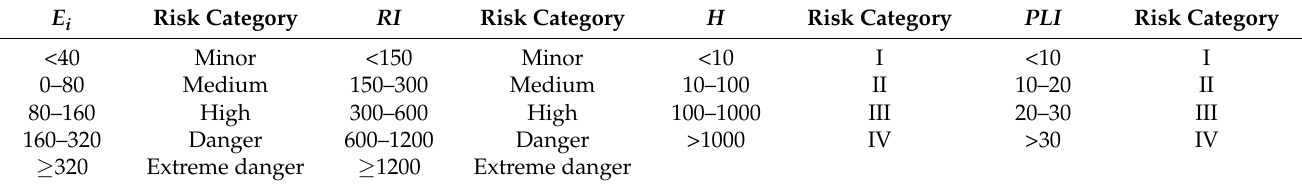
Table 1. The categories for ecological risks posed by